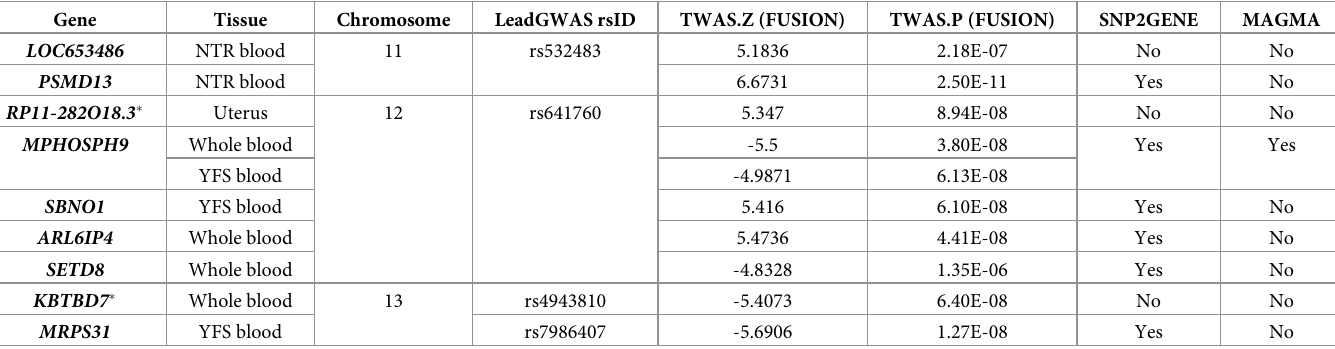
Table 1. A list of significant TWAS genes associated with UF (P < 1.90 × 10 − 6 ). Gene Tissue